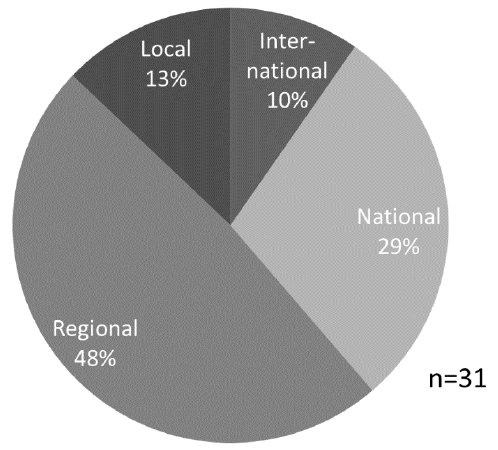
Figure 6. Role of landscapes’ stakeholders regarding different dimensions of local and regional development in the lower part of the Kovda River catchment.